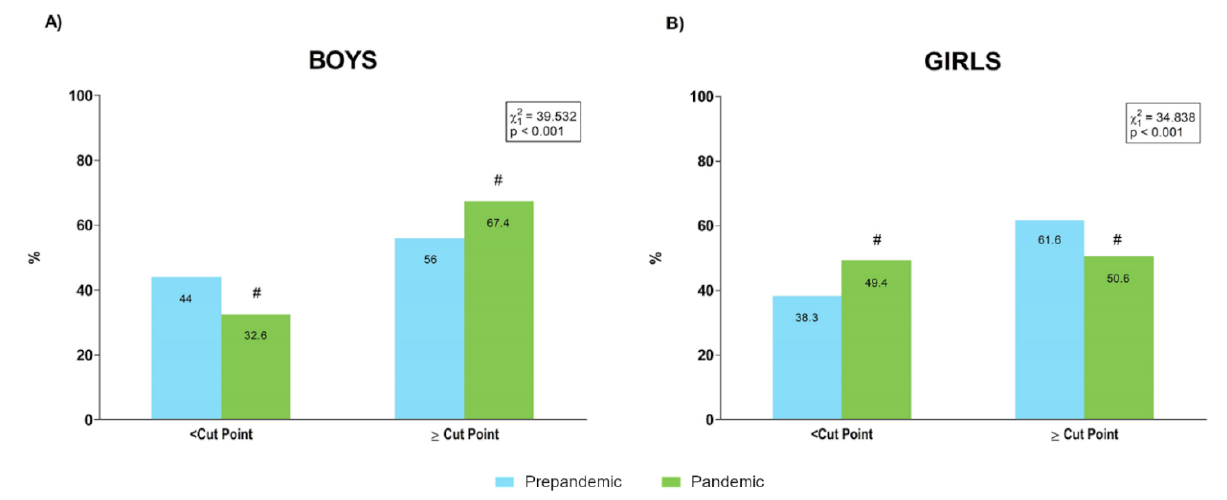
Figure 7. Percentages of boys ( A ) and girls ( B ) over and under cardiovascular risk handgrip per- formance cut points [34] before and during the pandemic. #: absolute value of the standardized residual ≥ 2 for this category.